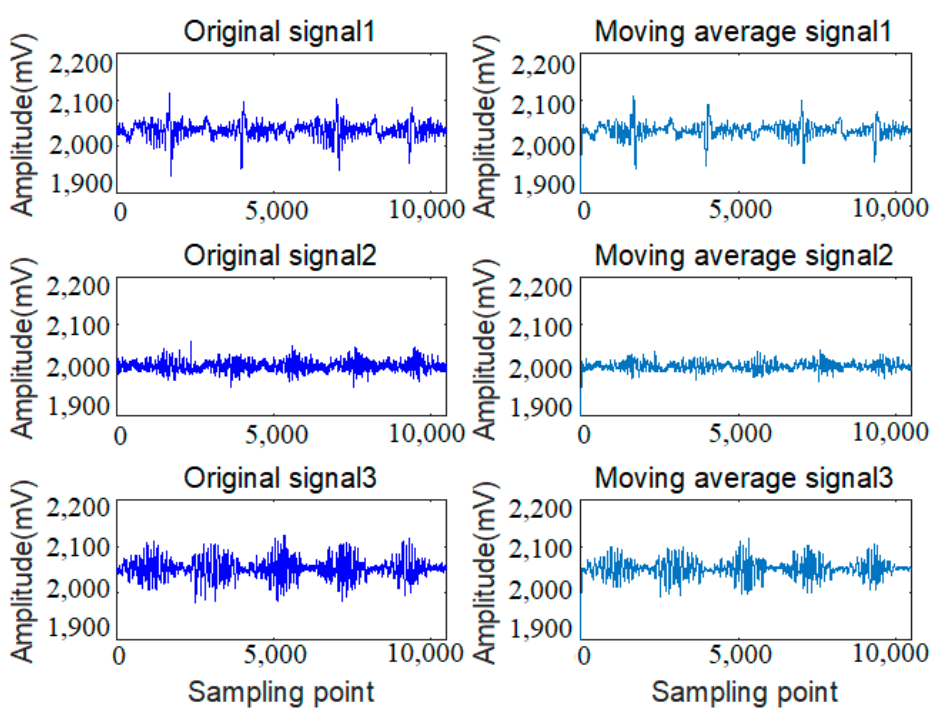
Figure 7. Weak signals processed by moving average method. The original weak signals of 1 to 3 correspond with the testing signals of S1 to S3 in Figure 5.